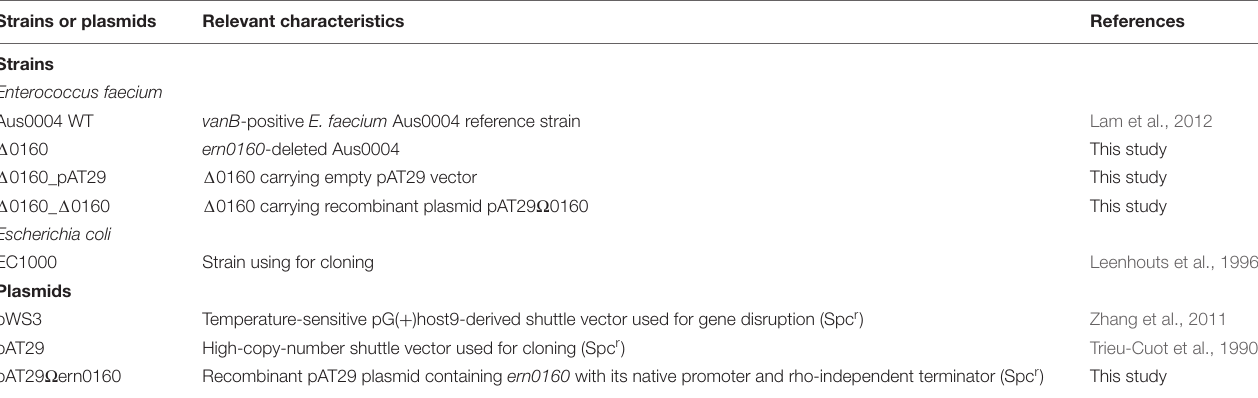
TABLE 1 | Bacterial strains and plasmids used in the study. Strains or plasmids Relevant